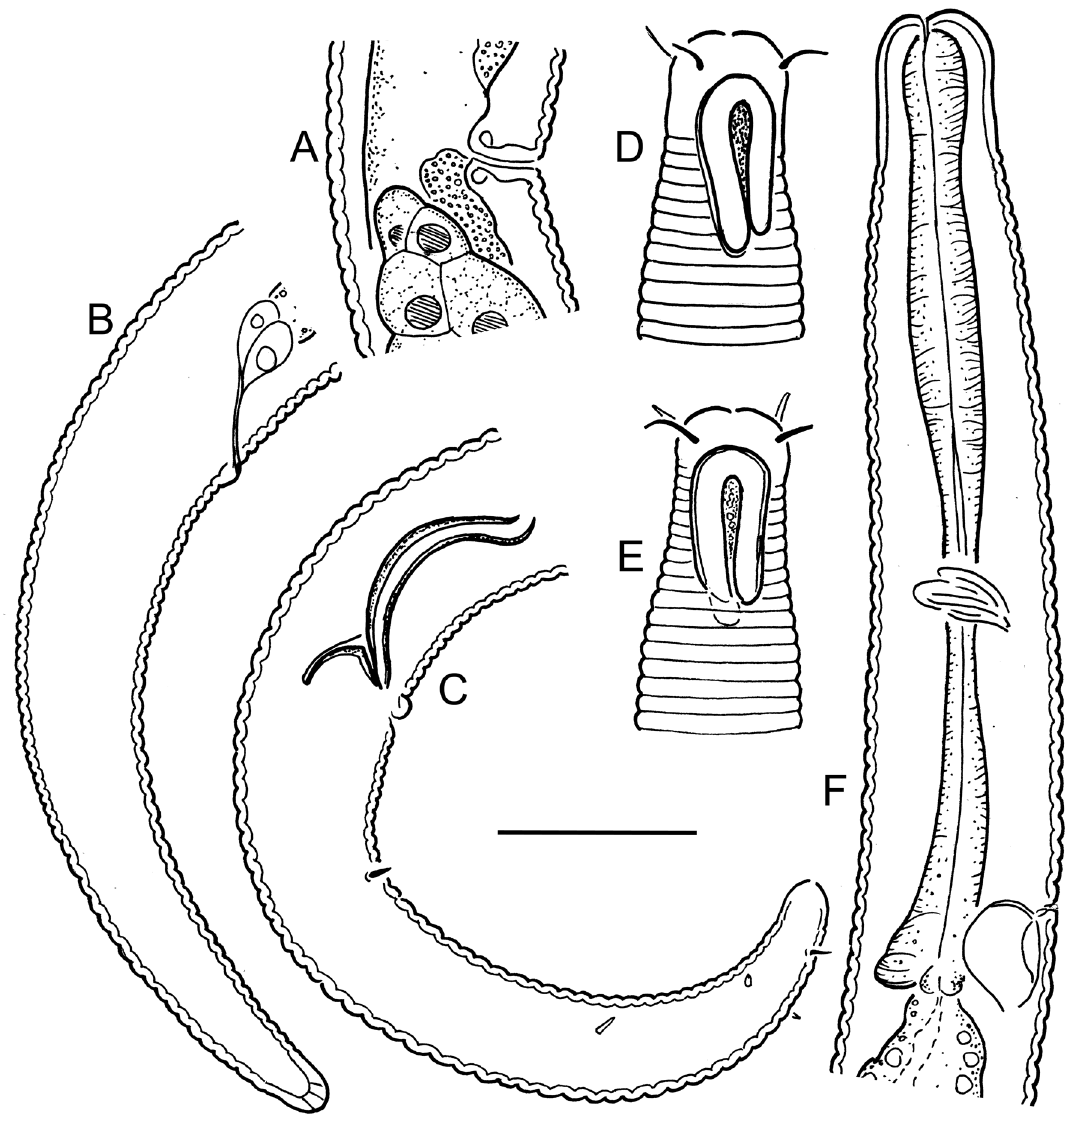
Fig. 4. Diplopeltoides asetosus (Juario, 1974) comb. nov. A . Vulval region. B . Female tail. C . Male tail. D . Female anterior end, surface view. E . Male anterior end, surface view. F . Female pharyngeal region, optical median section. Scale bar = 20